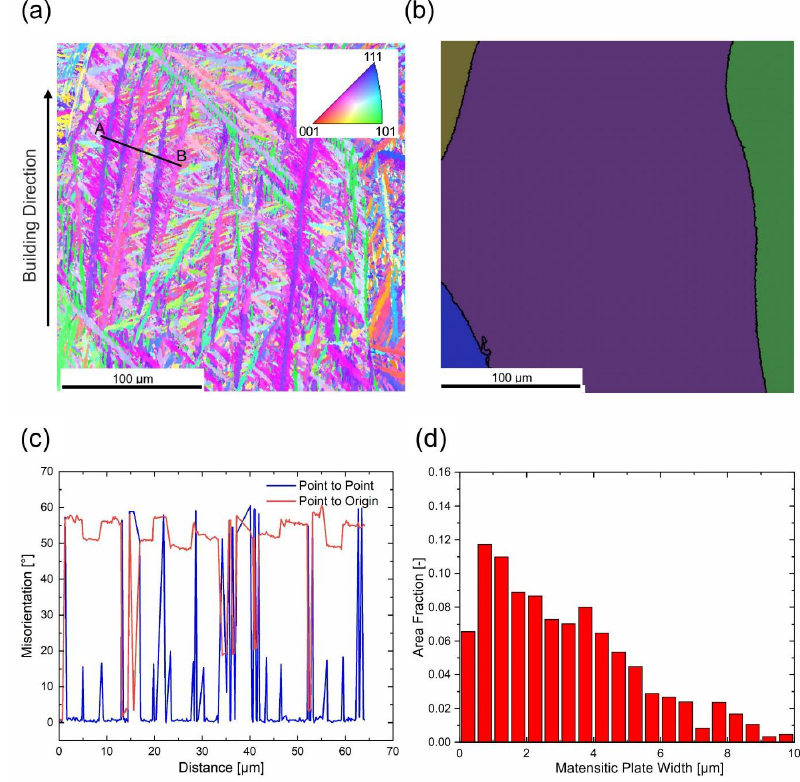
Figure 11. Microstructure analysis of the sample annealed and quenched in dilatometer. ( a ) Relative coarse martensite is presented by the IPF map. ( b ) The corresponding parent austenite is reconstructed based on EBSD result. ( c ) Point-to-point and point-to-origin misorientation profile of AB line in ( a ). ( d ) Martensitic plate width distribution.